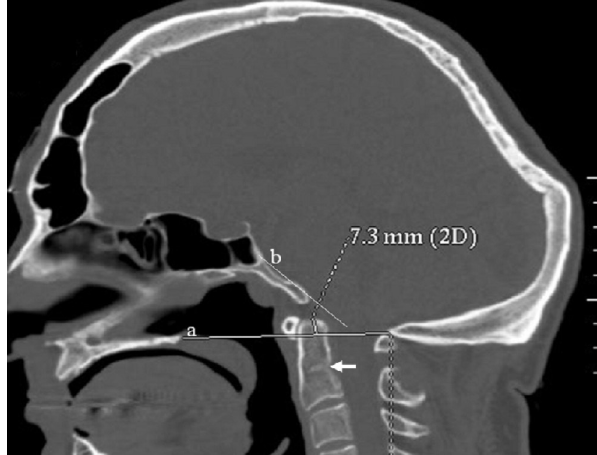
Figure 3 - A sagittal CT scan showed assimilation of the entire anterior arch of the atlas with the foramen magnum. The odontoid process was greater than 7.8 mm above Chamberlain's line* (a) associated with thinned and dysplastic clivus. Note the Wachenheim-Clivus line** (b) in our patient the line does not intersect and is not tangential to the odontoid process (this confirms the existence of marked craniocervical abnormalities). Severe platybasia associ- ated with significant distortion of the anatomical relations of the posterior fossa. Note the persistence of dentocentral synchondrosis (arrow). At this stage we planned for transoral odontoidectomy and posterior fixation of the occiput with the spinous processes of C2 -C3. *Chamberlain's line joins the hard palate to the posterior lip of the foramen magnum. Basilar impression is defined as being present when the tip of the dens projects more than 5 mm above Chamberlain's line.3 **Wachenheim clivus line (a method to evaluate and assess craniocervical junction abnormality/injury), a line drawn along the posterior aspect of the clivus toward the odontoid process. An abnormality is suspected when this line does not intersect and or / not tangential to the odontoid